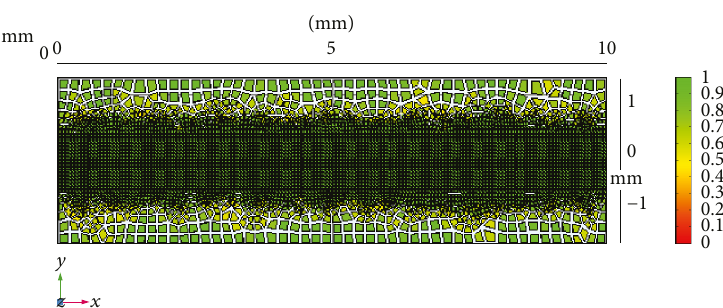
Figure 2: 3D FE mesh used for the numerical simulation of the SLM process.